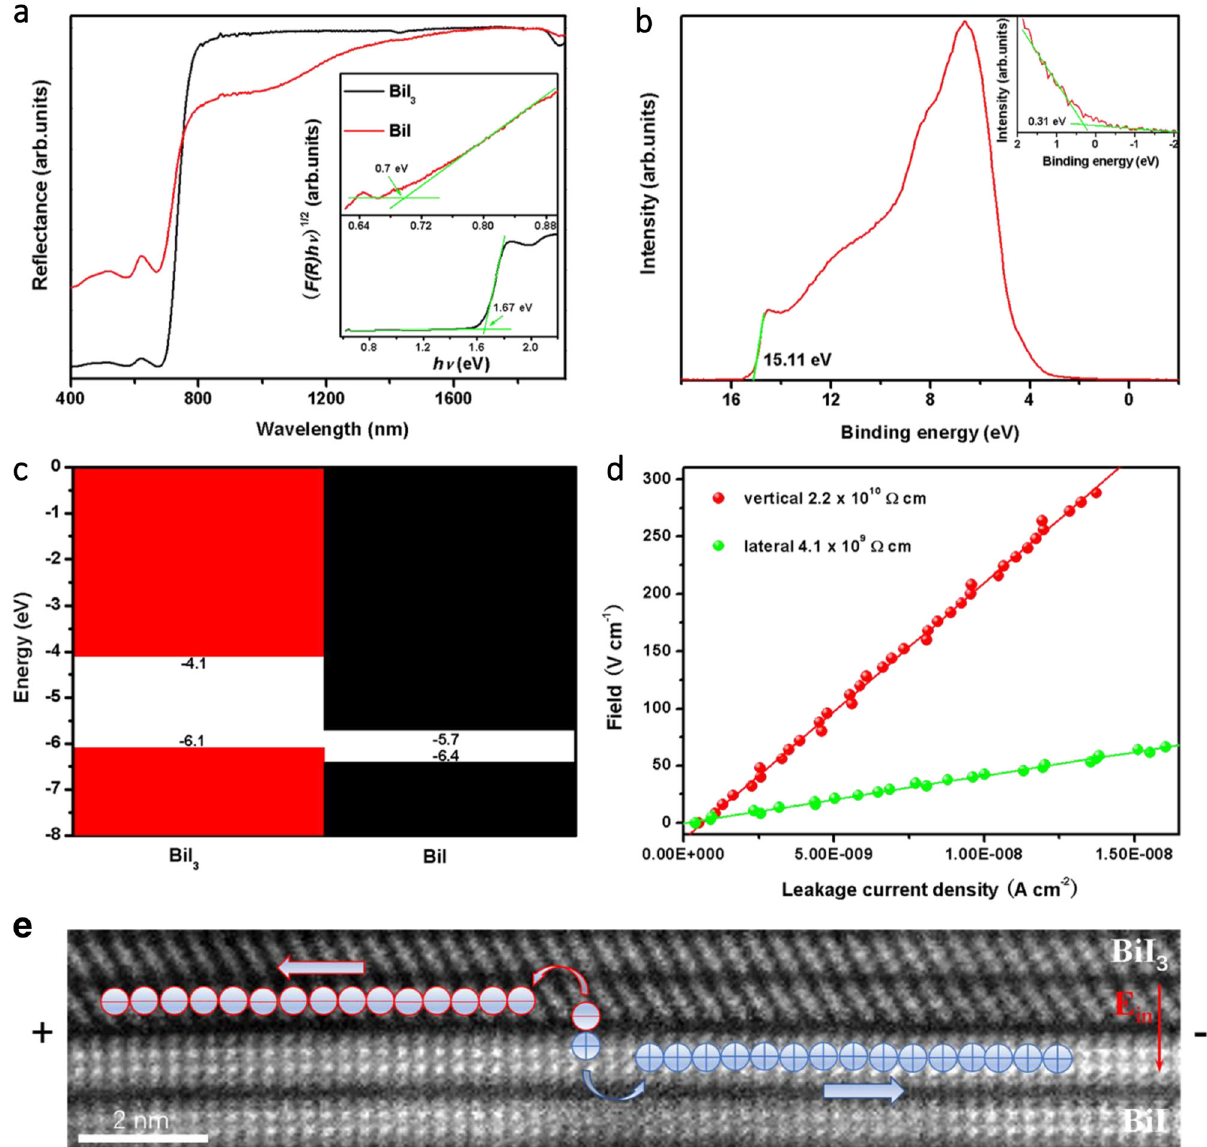
Fig. 3 | Band structure and charge separation kinetics of Bi x I y . a Diffuse re fl ectancespectraofcommercialBiI 3 andBi x I y .Inset:calculatedopticalbandgaps ofBiI 3 layerandBiIlayerintheBi x I y